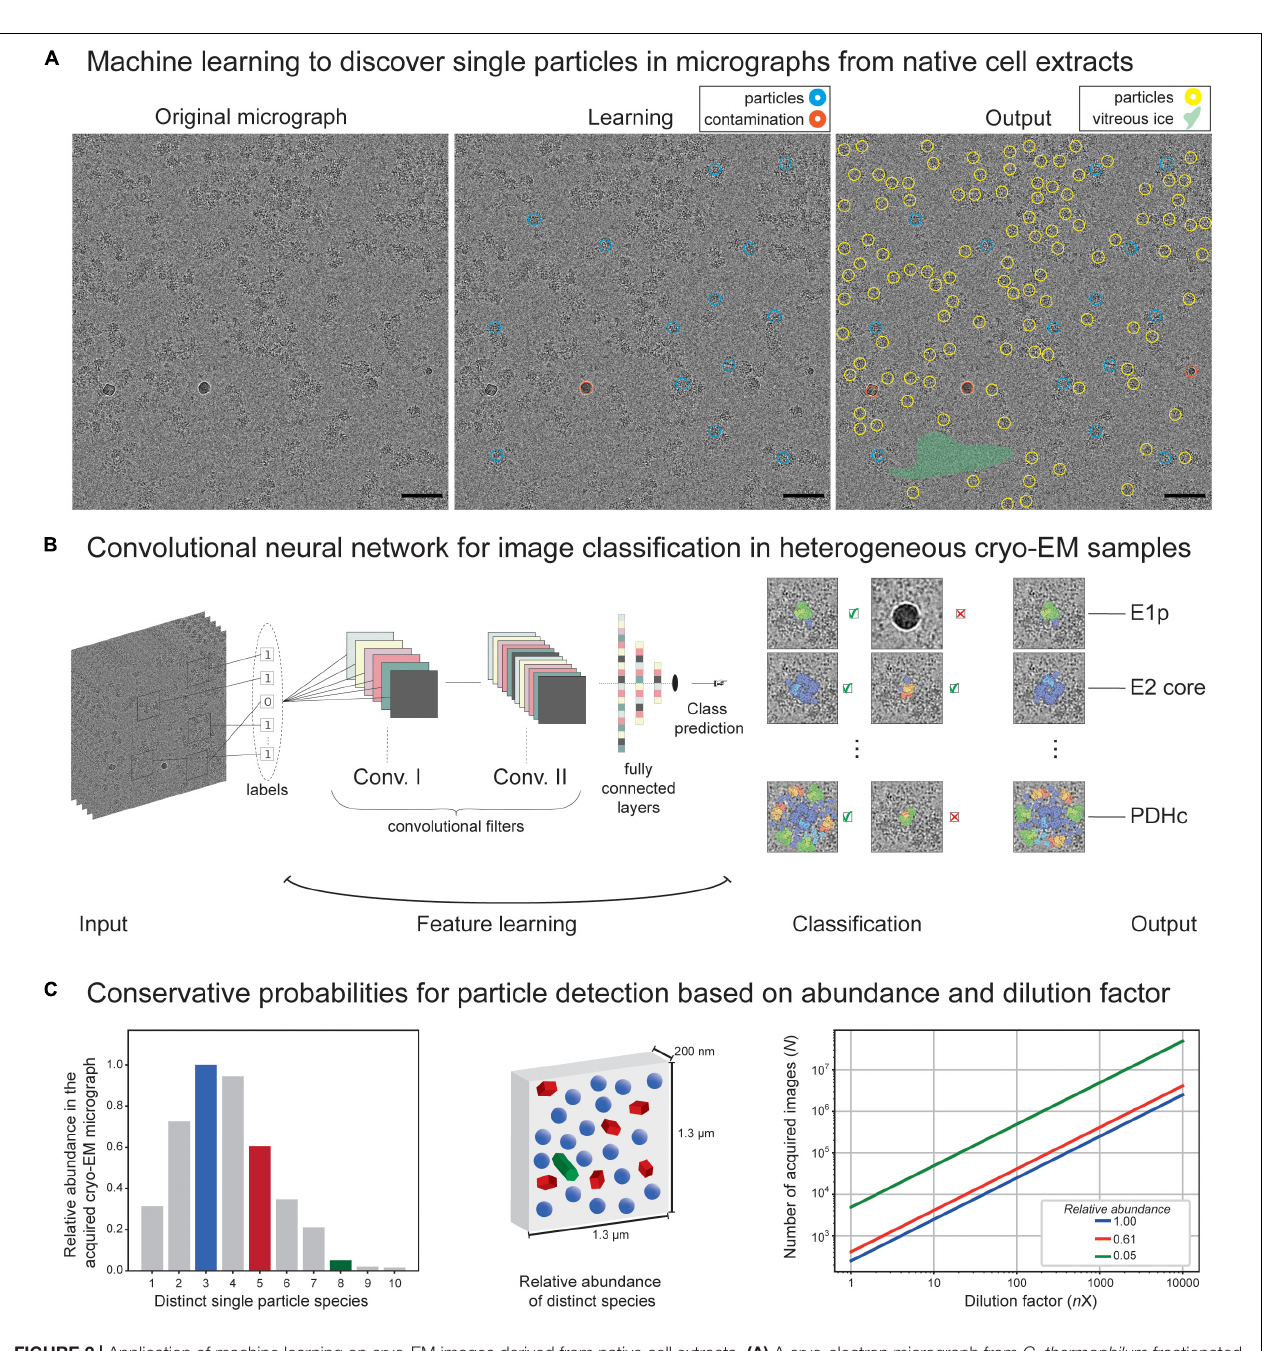
FIGURE 2 | Application of machine learning on cryo-EM images derived from native cell extracts. (A) A cryo-electron micrograph from C. thermophilum fractionated cell extracts is shown. During machine learning, the algorithm is being trained to discriminate particles from contamination, vitreous ice, aggregation, and noise. At the end, the algorithm optimally picks and selects learned features that were not previously recognized during learning. Red circles indicate contamination, and blue and yellow circles indicate learned and predicted particles. Size of the circle does not match particle size but represents a correctly picked particle. Green highlighted area signifies empty regions of vitreous ice recognized by the algorithm. (B) Structure of a convolutional neural network algorithm frequently used to detect signal in cryo-EM micrographs. Input micrographs are used for feature learning during the convolution step of algorithm training. Optimal training would lead to efficient classification of the single particles and/or their higher-order assemblies and discriminate those from noise, contamination, and aggregates. A final output is achieved with metabolon members in their unbound and bound states as recognized by the convolutional neural networks in heterogeneous cryo-EM micrographs of native cell extracts. (C) Conservative probabilities for particle detection based on abundance and dilution factor. In the left panel, an example of 10 distinct single-particle species is shown with their relative abundance following an assumed T-squared distribution. In the middle panel, an illustration of relative particle abundance for three distinct particles (blue, green, and red, representing high, medium, and low abundant species in a calculated 4K × 4K micrograph with a pixel size of 3.17 Å and thickness of 200 nm) is shown. In the right panel, dependency of the number of images required to reach ∼ 5,000 single particles on the dilution factor is shown (assuming no biochemical manipulation for particle